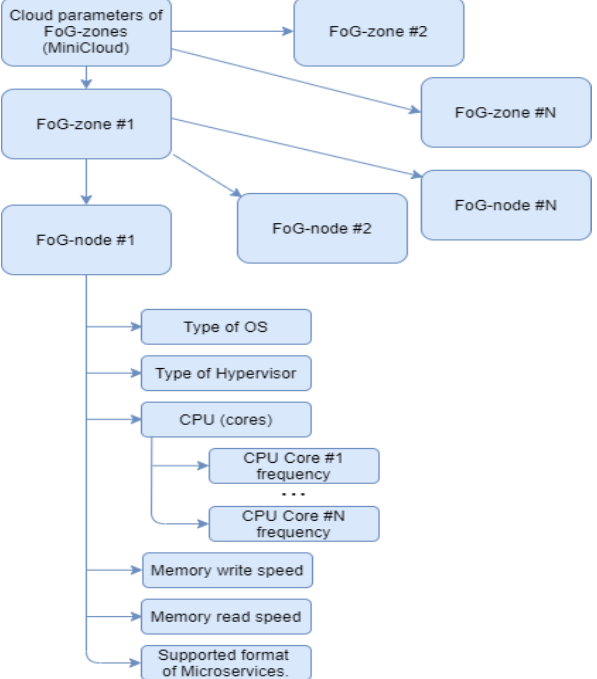
Figure 6. The structure of the transmitted